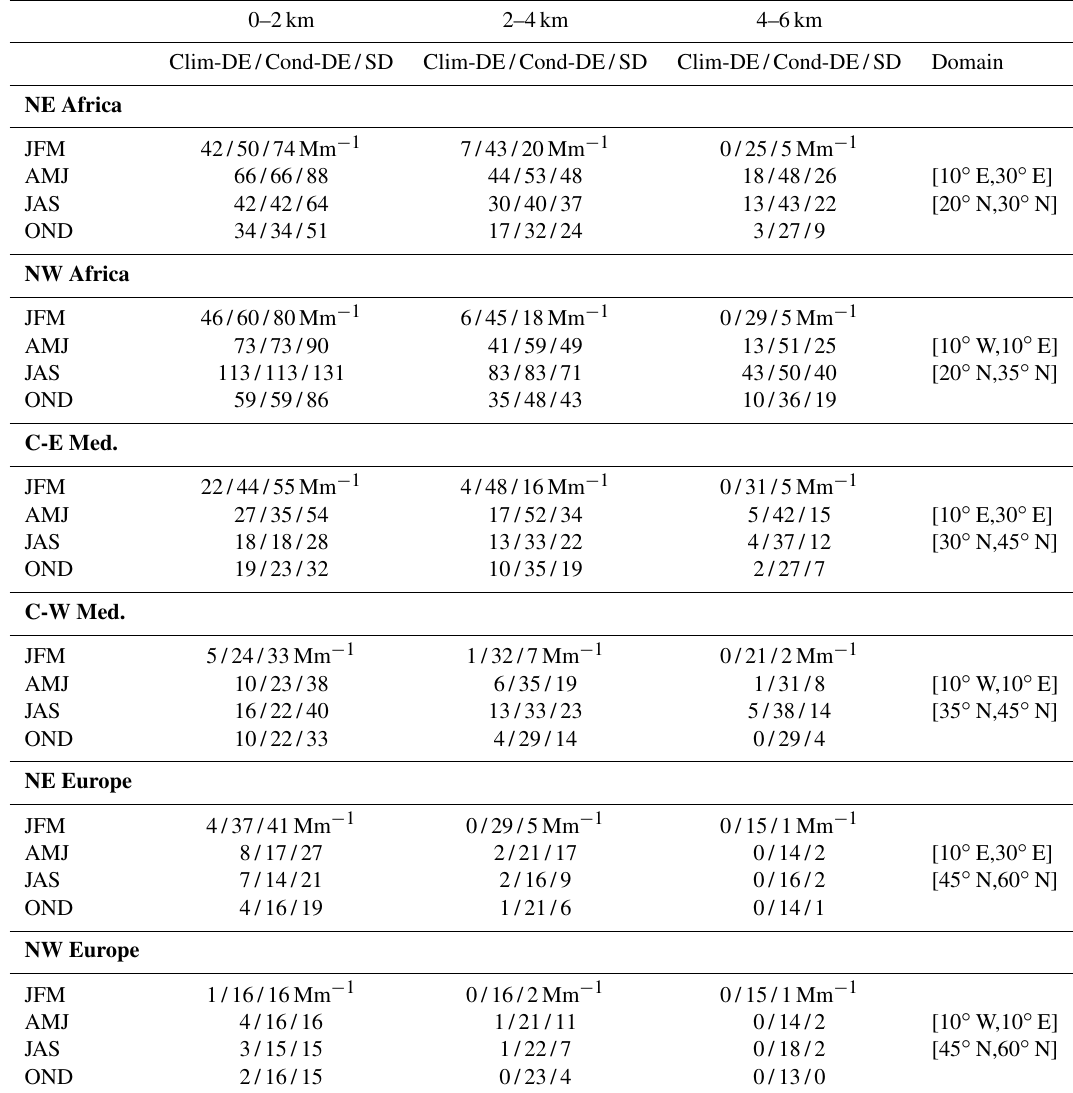
Table 3. Regional statistics on the dust extinction coefficient for altitudes between 0 and 2km, 2 and 4km and 4 and 6km